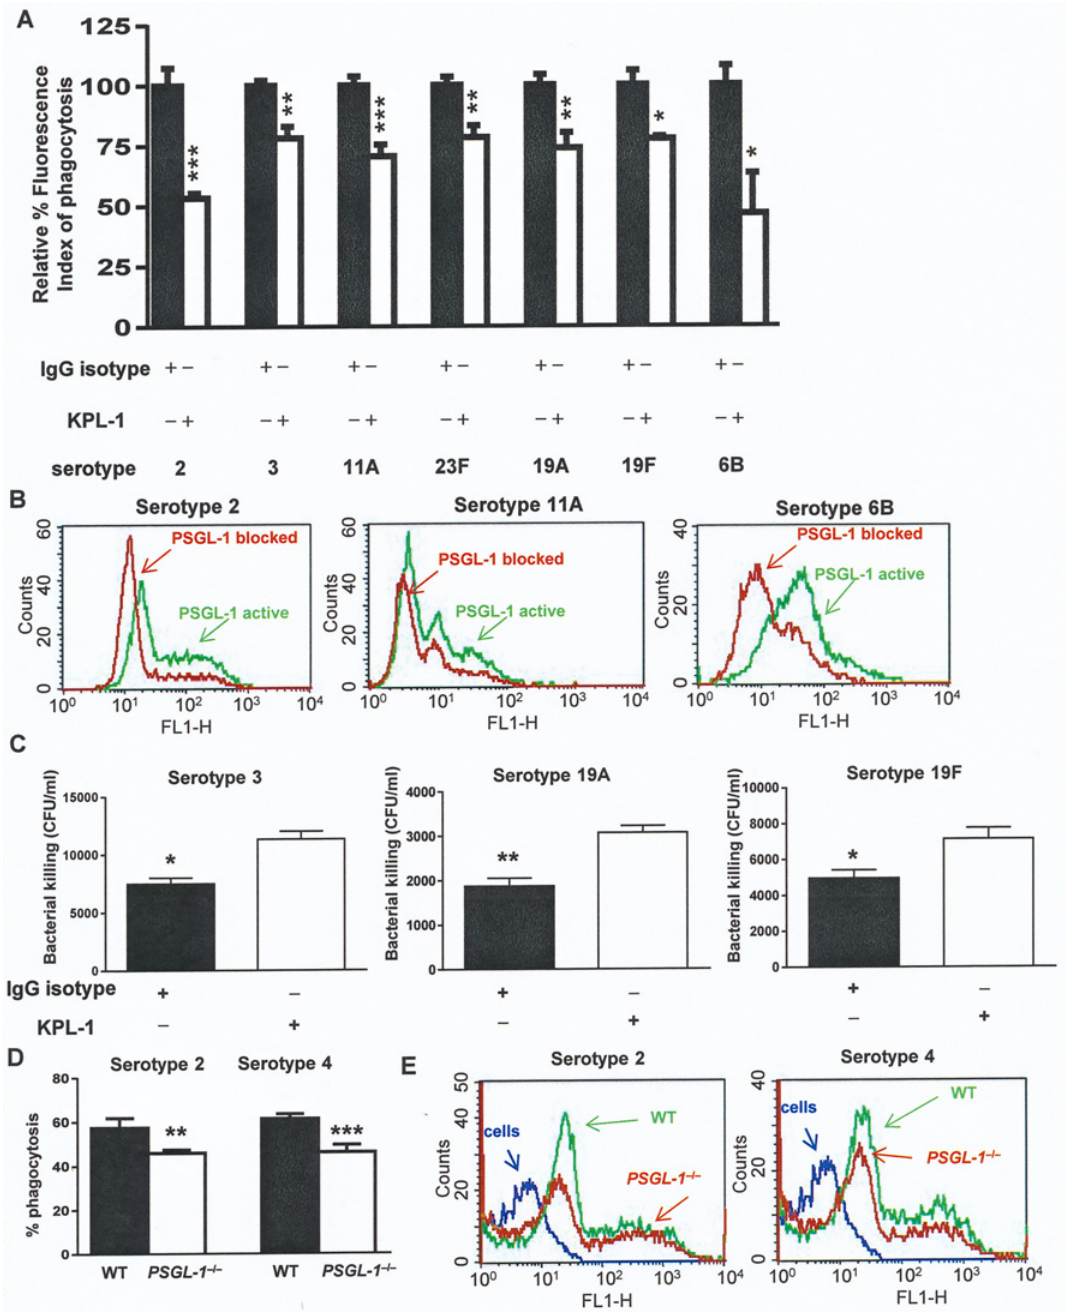
Fig 1. PSGL-1 on HL-60 cells and murine neutrophils is required for phagocytosis of S . pneumoniae . (A) Phagocytosis mediated by PSGL-1 of FAM-SE-labeled pneumococcal clinical isolates belonging to different serotypes using a flow cytometry assay. HL-60 cells were incubated with an IgG isotype negative control that does not block PSGL-1 (black bars), whereas cells exposed to the KPL-1 antibody had the PSGL-1 blocked (open bars). (B) Examples of flow cytometry histograms of pneumococcal binding to cells incubated with KPL-1 (red) or IgG control (green). (C) Bacterial survival indicated as CFU/ml of recovered bacteria from HL-60 cells previously exposed (open bars) or not (black bars) to KPL-1. (D − E) Phagocytosis of FAM-SE-labeled D39 strain by neutrophils isolated from the spleen of wild-type (black bar and green histogram) or PSGL-1 – / – mice (open bar and red histogram). The blue line in the histogram shows the pattern of non-infected cells. Error bars represent the SDs and asterisks indicate statistical significance after incubation with KPL-1 compared to the exposure to IgG isotype control or between OP using neutrophils from wild-type mice vs those from PSGL-1 – / – mice.